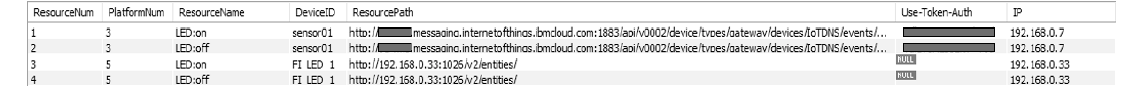
Figure 15. IoT DNS database example.